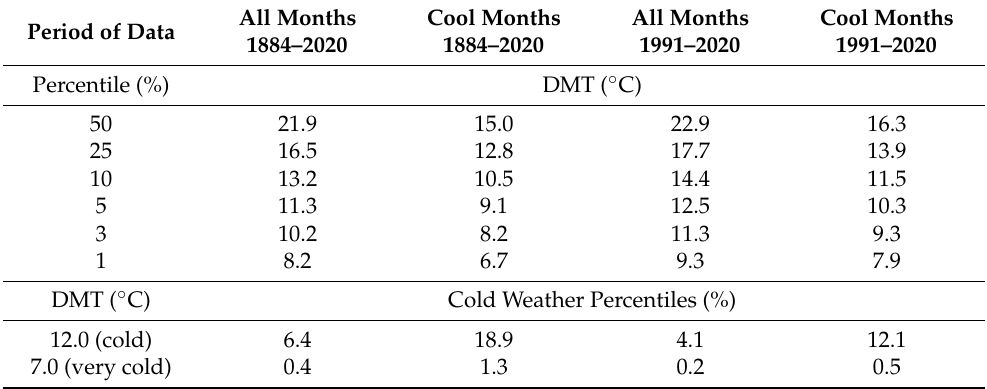
Table 1. Key percentiles in climatological distribution of daily minimum temperatures (DMT) recorded at HKO and the percentiles corresponding to “cold” and “very cold” days in Hong Kong. All Period of Data